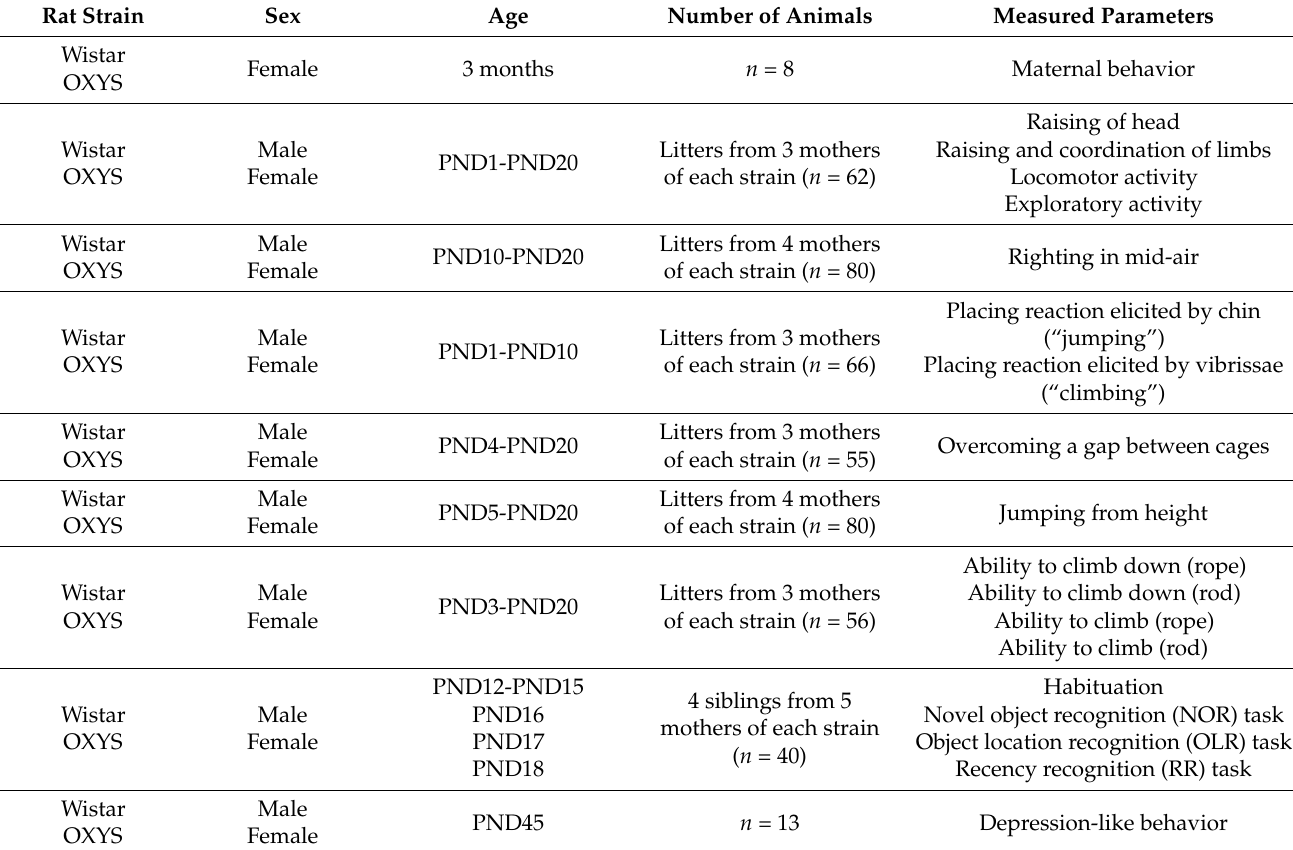
Table 1. The scheme of the